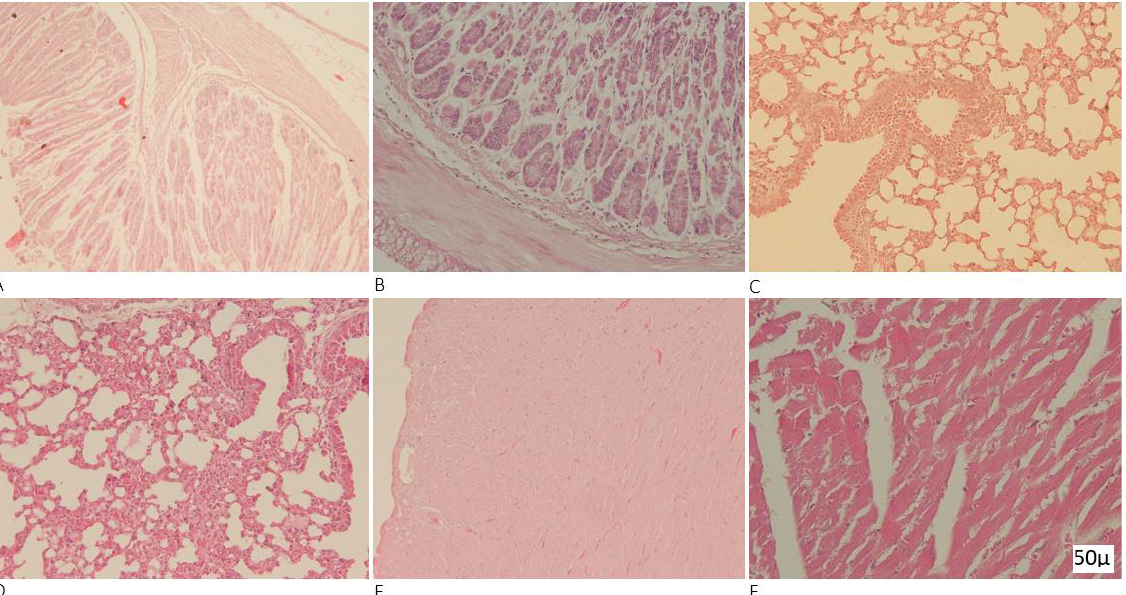
Figure 5. Cross-section of HE stain A. normal B. DPP treatment at a dose of 56 mg/kg/d on mouse stomach; C. normal D. DPP treatment at a dose of 56 mg/kg/d on mouse lung; E. normal F. DPP treatment at a dose of 56 mg/kg/d on the heart (Febrian, 2018)..